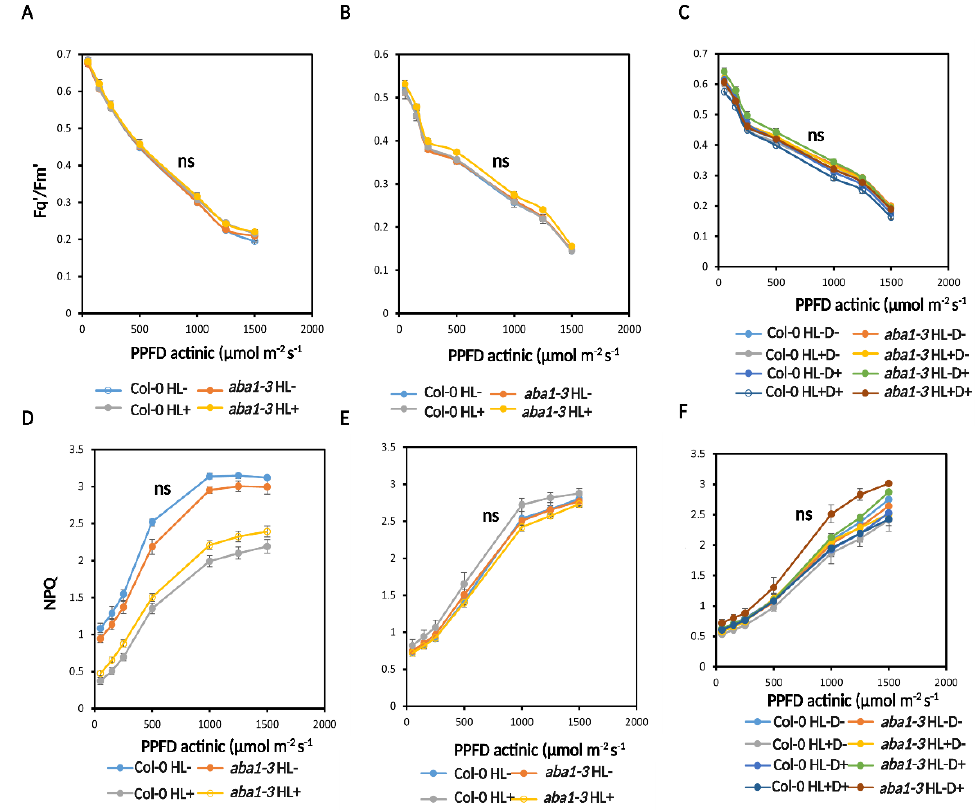
Figure 7. Photosynthesis performance was not affected in response to D and HL. ( A ) Photosynthesis operating efficiency measured by CF imaging using a light response curve of actinic light between 50–1500 µmol m −2 s −1 after HL stress. ( B ) Photosynthesis operating efficiency measured after recovery stress. ( C ) Photosynthesis operating efficiency measured after D stress. ( D ) NPQ measured using a light response curve of actinic light between 50–1500 µmol m −2 s −1 after HL stress. ( E ) NPQ measured after recovery. ( F ) NPQ measured after D stress. The second biological replicates are shown in Supplementary Figure S10. Statistical significance analyzed by one-way ANOVA test and post-hoc Tukey’s HSD test. ns = not significant.